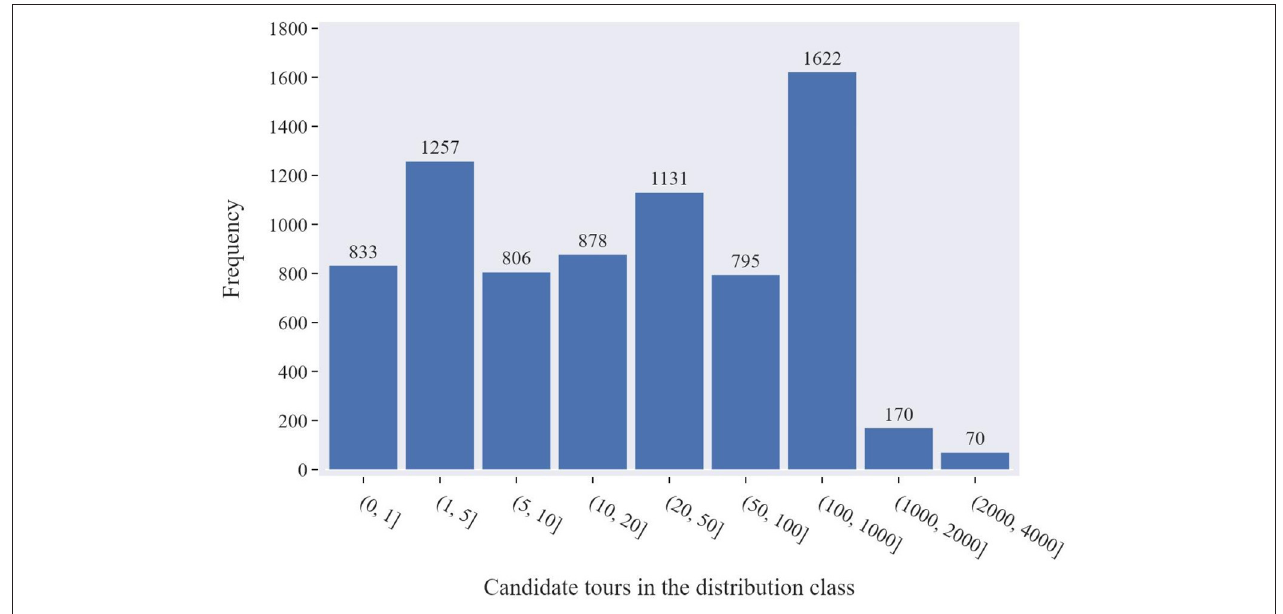
FIGURE 6 | Distribution of the number of candidate tours in the distribution classes.